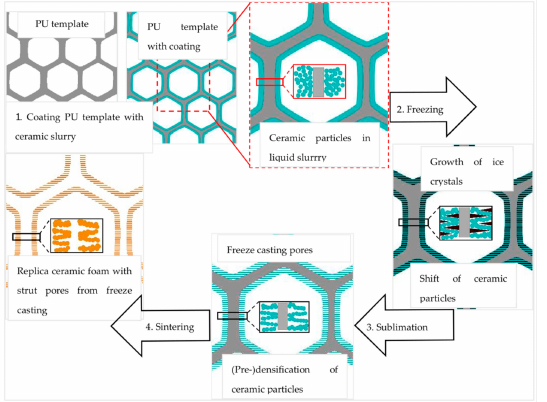
Figure 1. Illustration scheme of the experimental procedure for manufacturing alumina freeze-dried replica